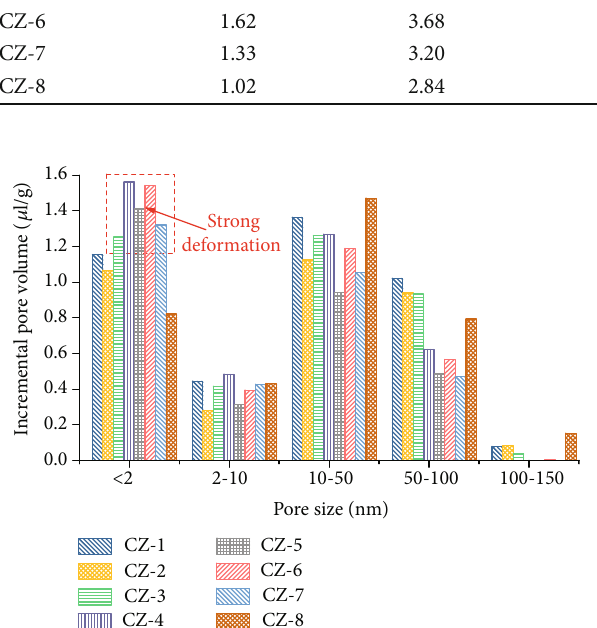
Figure 5: Pore surface distribution of the Lujiaping shale from the data of LPGA